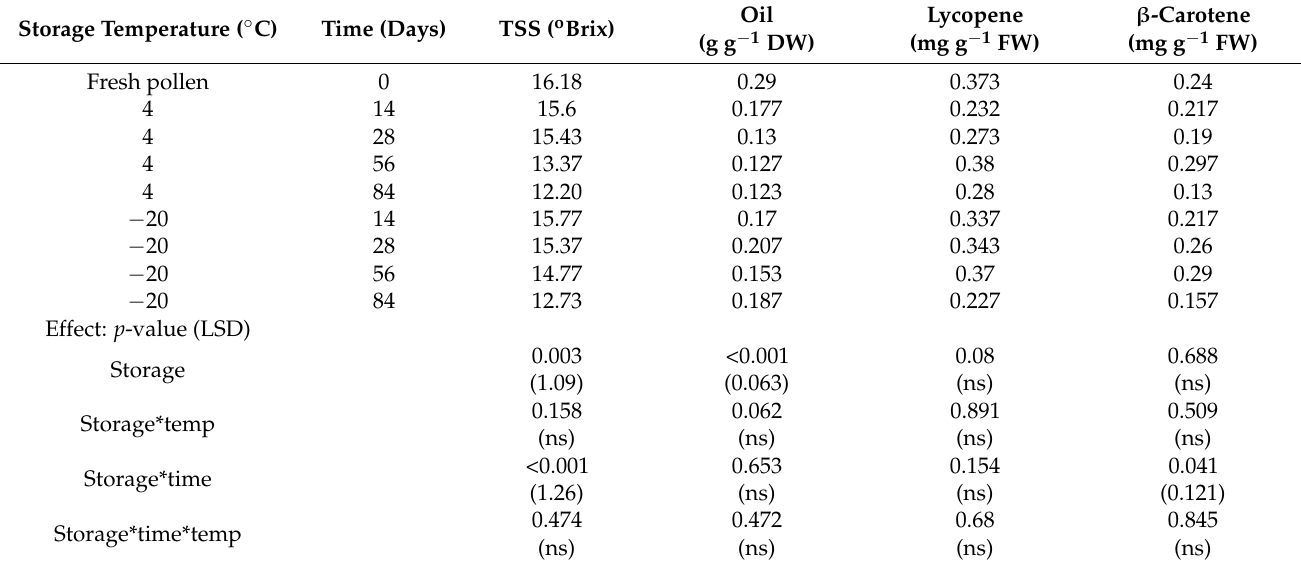
Table 2. Some chemical characteristics of Gac aril from fruits originally pollinated with fresh and cool-stored pollen. Values are means ( n = 3) and the significant effects of factors and their interactions are included. (TSS-total soluble solids,